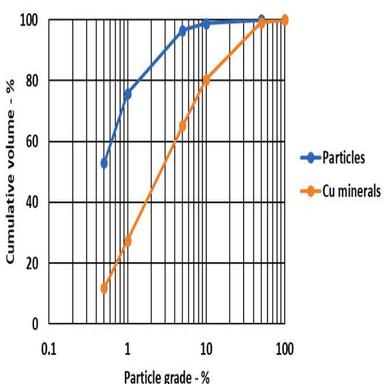
Particle grade analysis. Cumulative volume of particles VS. particle grade curve and cumulative volume of Cu minerals VS. particle grade curve are presented.